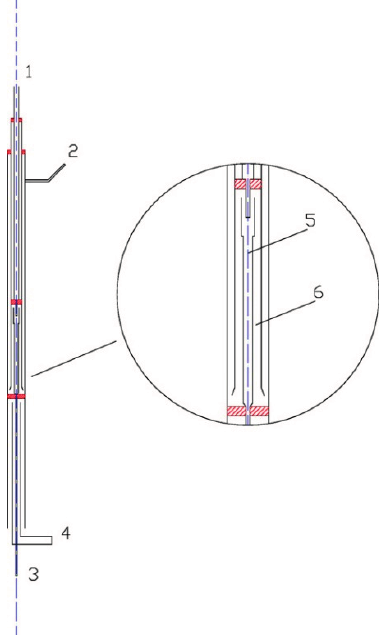
Figure 2. Schematic of the quartz flow reactor. (1) Inlet 1; (2) Inlet 2; (3) Outlet; (4) Air cooling; (5) Quartz flow reactor; (6) Preheat channels